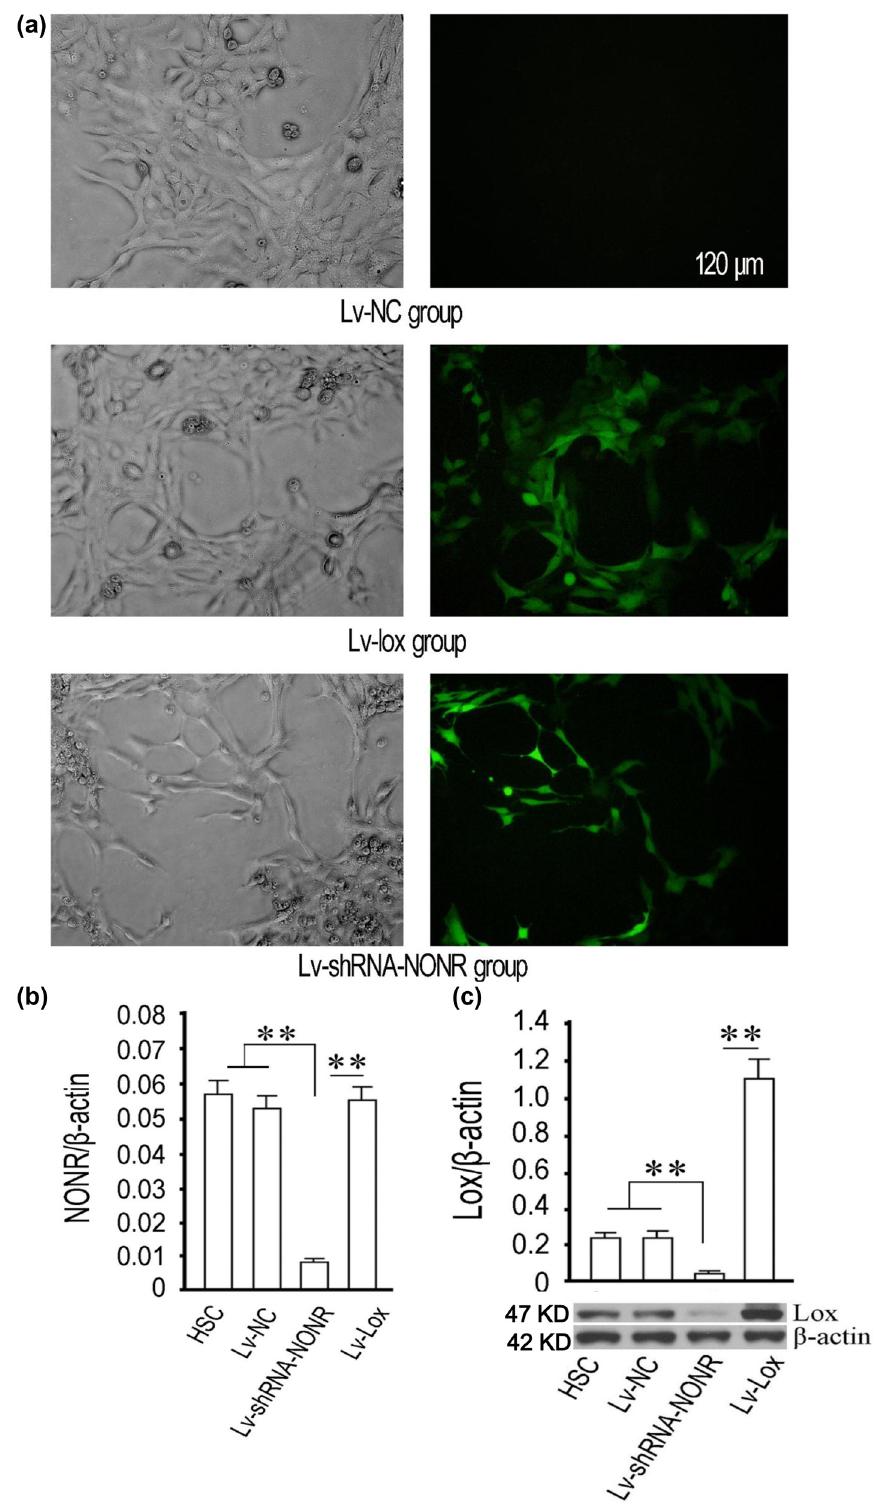
Figure 3: Lentiviral pathway - mediated silencing of NONRATT013819.2 and overexpression of lox gene in HSCs. ( a ) The lentivirus - mediated NONRATT013819.2 silencing was demonstrated by GFP green fl uorescent protein ( MOI = 10 ) . ( b ) RT - qPCR was used to detect the relative amount of NONRATT013819.2. ( c ) Western blotting was used to detect the relative protein expression of Lox. * P < 0.05, ** P <